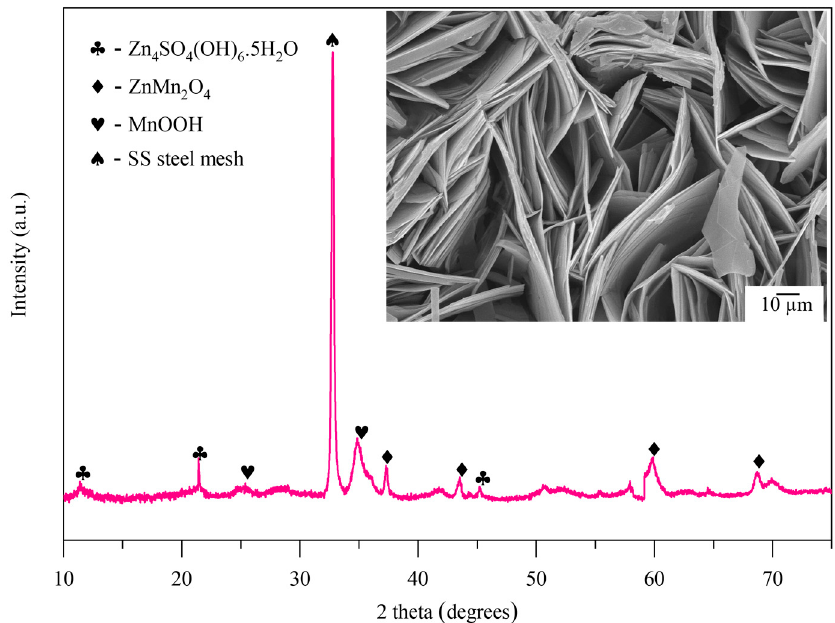
Figure 7. Ex situ X-ray diffraction pattern and ex situ SEM (inset) of the δ -MnO 2 electrode after 200 cycles.